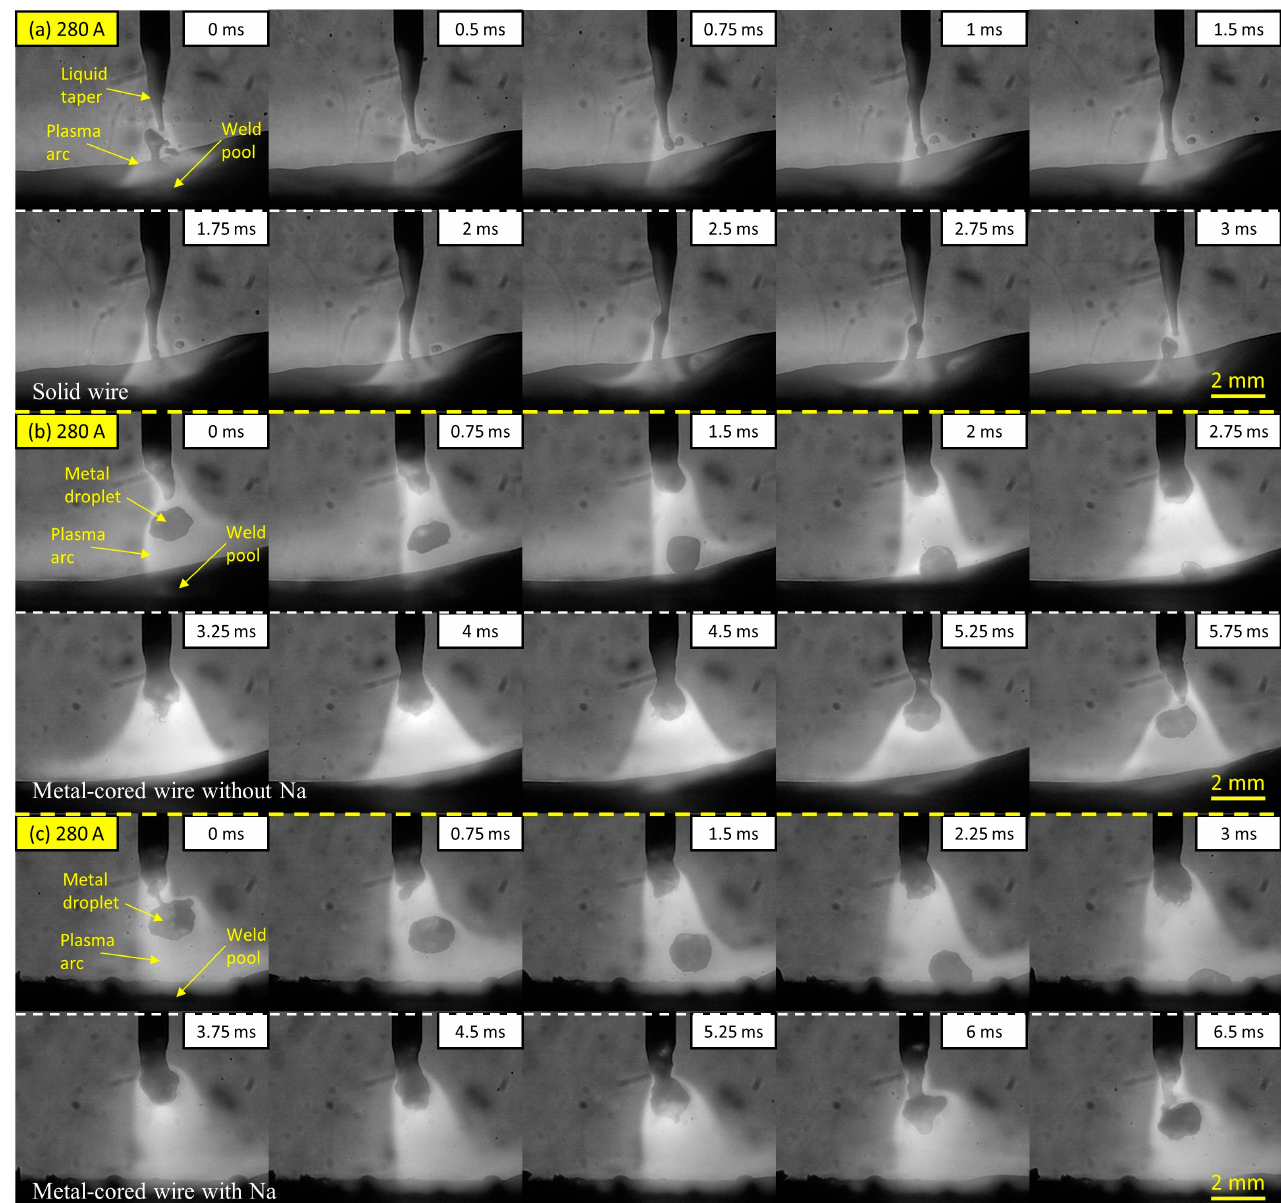
Figure 2. Metal transfer in wire 1 ( a ), wire 2 ( b ), and wire 3 ( c ) at 280 A welding